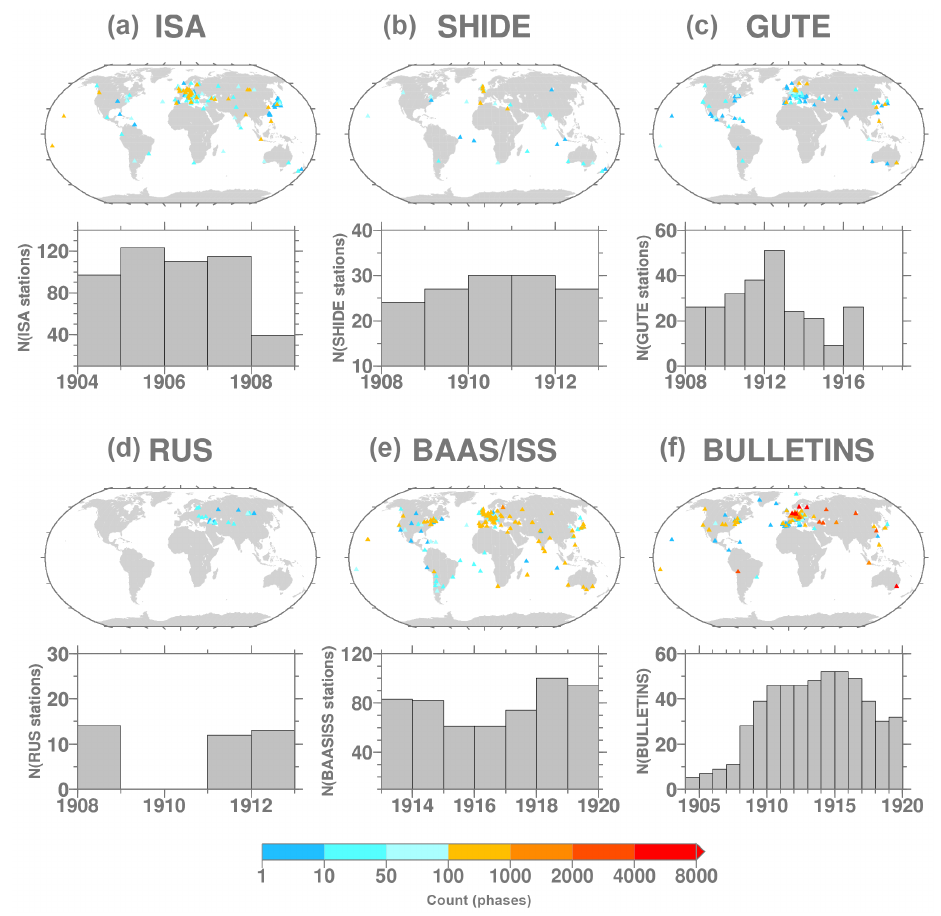
Figure 13. Station data contributions from ISA (a) , SHIDE (b) , GUTE (c) , RUS (d) , BAAS and ISS (e) and BULLETINS (f) identifying the individual/network station bulletins. The stations are colour-coded by number of phases digitised (see text for details). For each station data source, the annual station counts are shown below the corresponding map (note the different scales for each